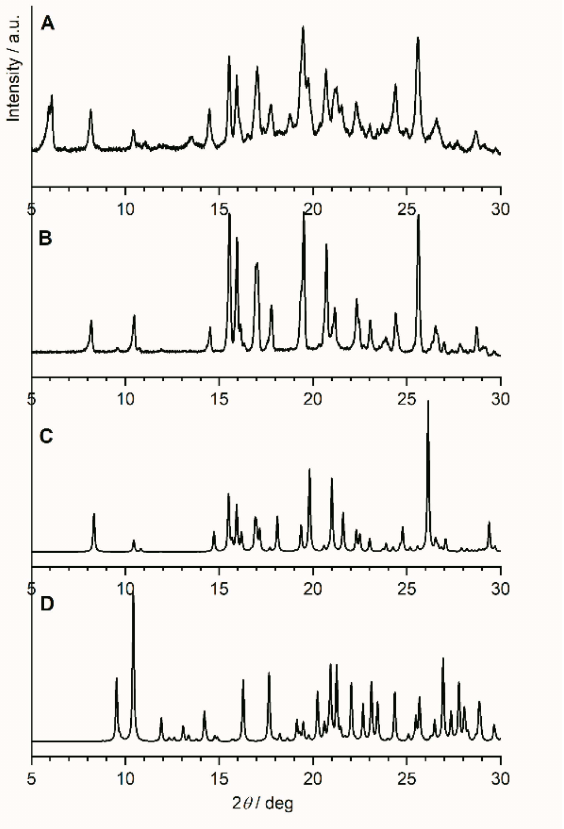
Figure 2. Powder X-ray diffraction patterns of famciclovir (FAM). ( A ) After and ( B ) before heating and cooling from RT to 110 ◦ C/ − 50 ◦ C at a heating rate of 6 ◦ C/min, ( C ) the pattern of anhydrous famciclovir calculated from single-crystal data discussed in chapter 2.2 (vide infra), and ( D ) the calculated pattern of the hydrated form of famcicolovir reported under the structure code YACHAL in the Cambridge Crystallographic Database and published by Harnden et al.